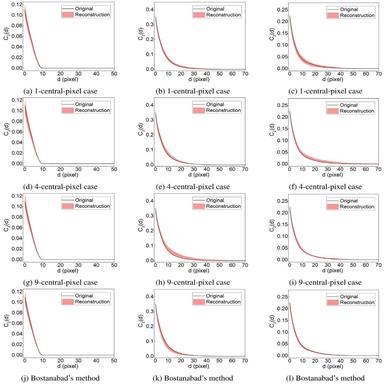
Comparison of TPCCF C2(d) between the original microstructures and the corresponding reconstructed microstructures from the proposed method and Bandstand's method.